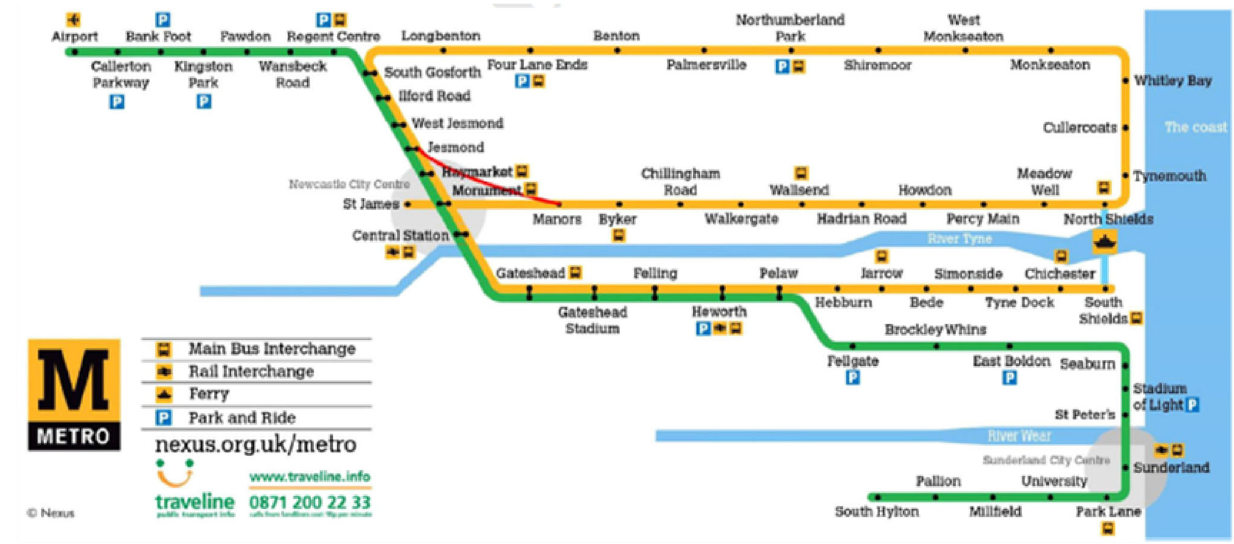
Fig. 4 Metro map, showing the track between Jesmond and Manors